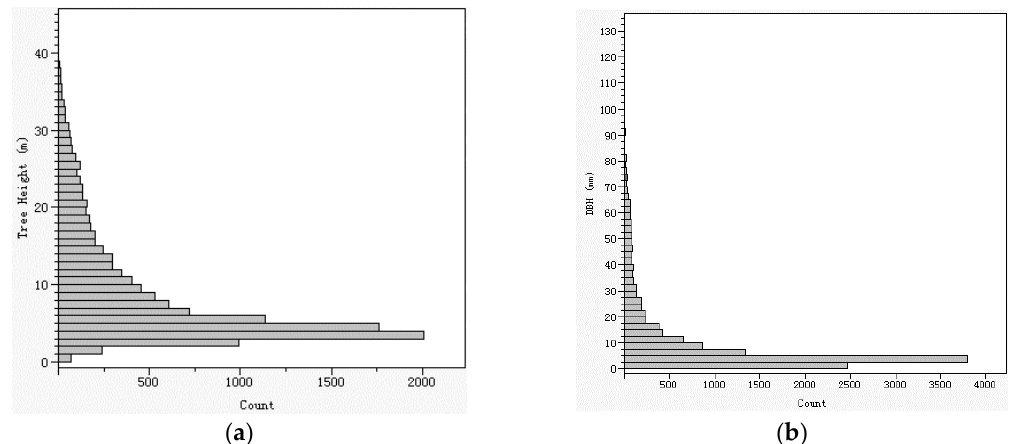
Figure 1. Distribution of the tree height and DHB in the sample plot. ( a ) Distribution of the tree height; ( b ) Distribution of the DBH.